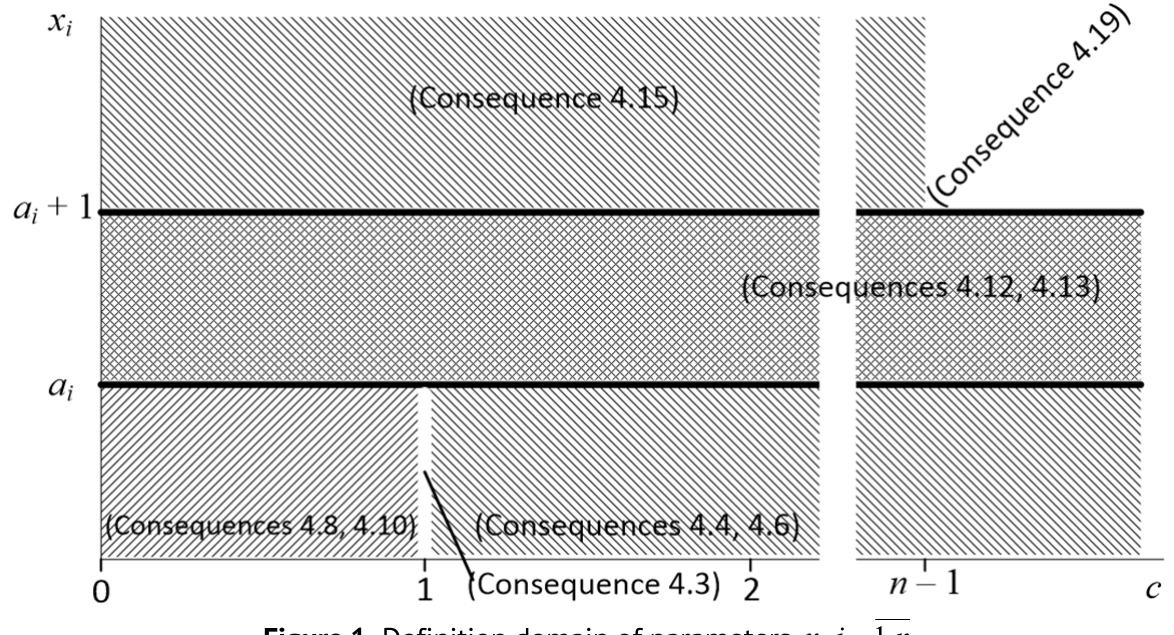
Figure 1. Definition domain of